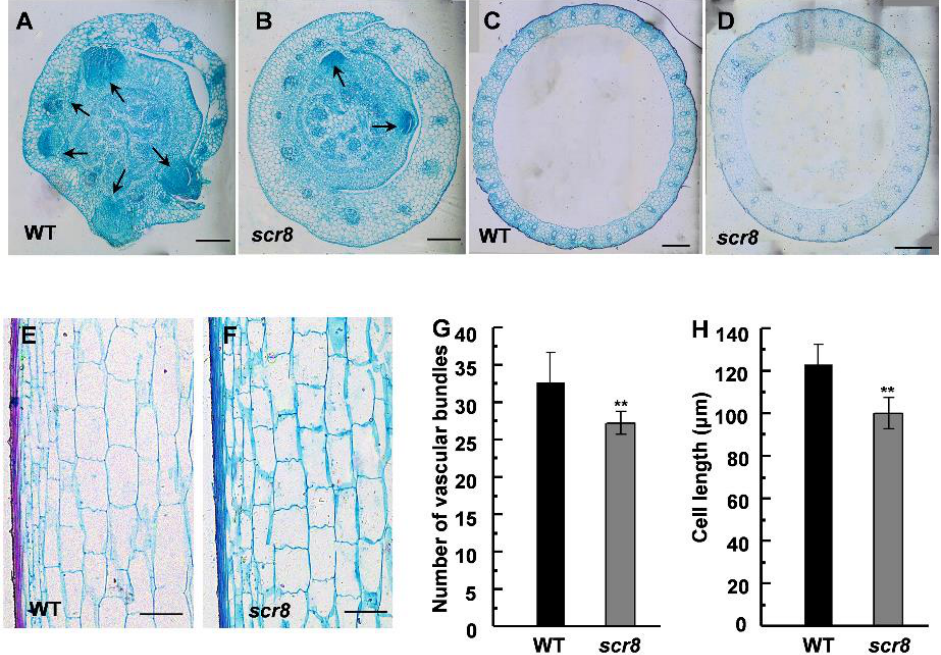
Figure 3. Histological characterization of basal nodes and culms. ( A , B ) Cross sections of basal nodes from WT and scr8 mutant plants. Arrow represents crown root primordia. Scale bars, 200 µ m. ( C , D ) Cross sections of culms from WT and scr8 mutant plants. Scale bars, 200 µ m. ( E , F ) Longitudinal sections of culms from WT and scr8 mutant plants. Scale bars, 100 µ m. ( G ) Average number of vascular bundles of culms in WT and scr8. ( H ) Average cell length of culms in WT and scr8. Error bars represent SD. ** Significant difference at p < 0.01 compared with the WT by Student’s t -test.